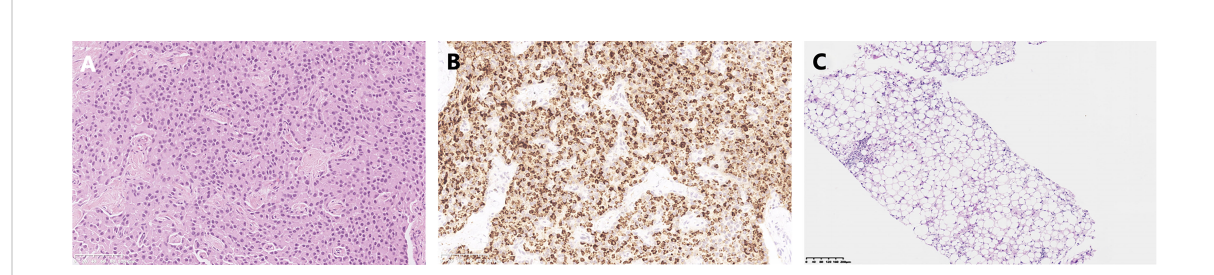
FIGURE 2 Pathological results. (A) Hematoxylin-eosin staining of the pancreatic neuroendocrine neoplasm. (B) Somatostatin immunostaining. (C) Biopsy of the liver